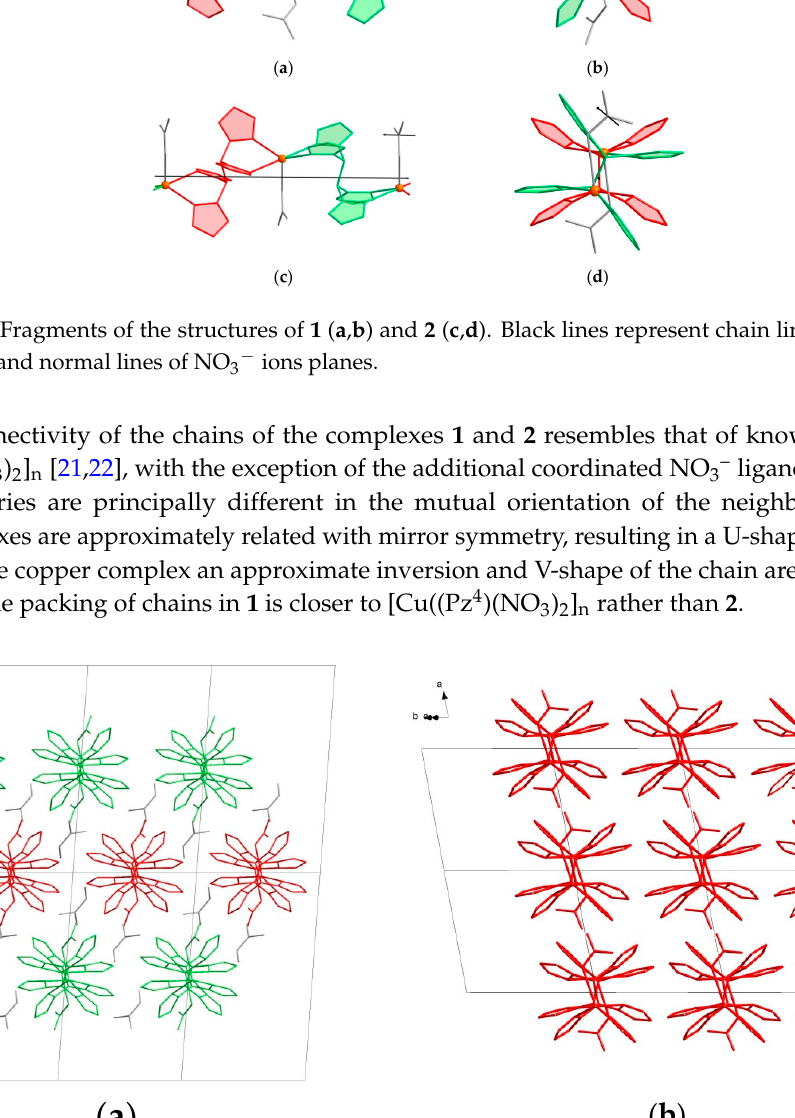
Figure 4. Packing patterns of the polymeric chains of the complexes 1 ( a ) and 2 ( b ).